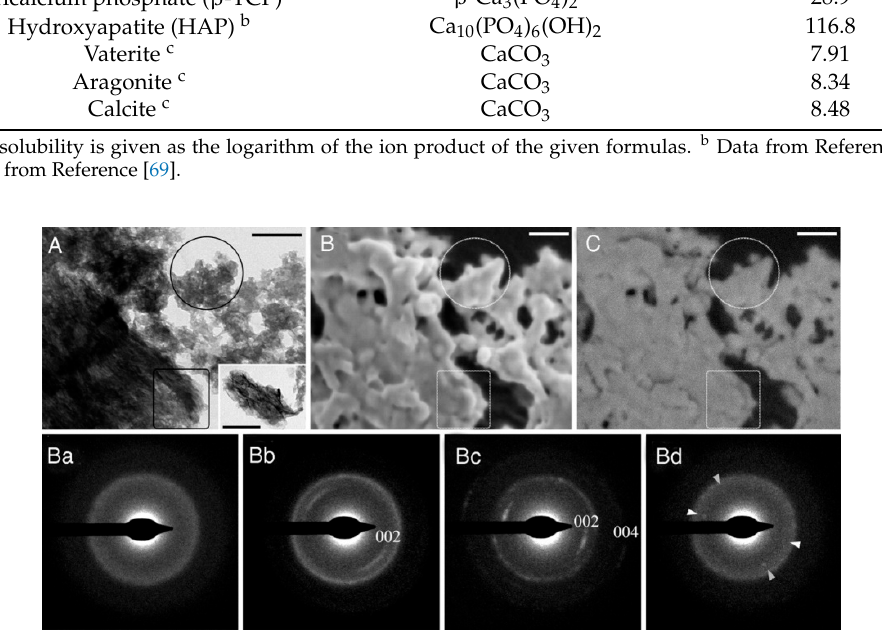
Figure 2. TEM and selected area electron diffraction patterns (SAED) correlated with SEM and energy selective backscattered (ESB) imaging of mineral freshly extracted from the distal end of the fin. ( A and B.a–B.d ) TEM micrograph of mineral particle aggregates and the corresponding SAED patterns: encircled particle produces amorphous scatter of diffuse rings (SAED, B.a ). Area marked with a rectangle produces poorly crystalline diffraction (SAED, B.b ), and particle in Inset produces a clear crystalline diffraction pattern (SAED, B.c ), showing well defined reflections of the (002) and second order (004) apatite planes. (SAED B.d ), corresponds to the encircled area examined after storage for 1 week at room temperature: As the particles begin to crystallize, diffraction spots with spacing of the (002) plane appear (arrowheads), implying conversion into a crystalline apatite phase. ( B ) High- resolution cryo-SEM micrograph of the same particle, uncoated, taken after examination in the TEM. ( C ) Corresponding ESB image, showing no distinguishable difference between the signal intensity of the amorphous (encircled area) and crystalline (rectangular area) mineral parts. (Scale bars 100 nm.) Reproduced with permission from Reference [64] Copyright (2008) National Academy of Sciences,